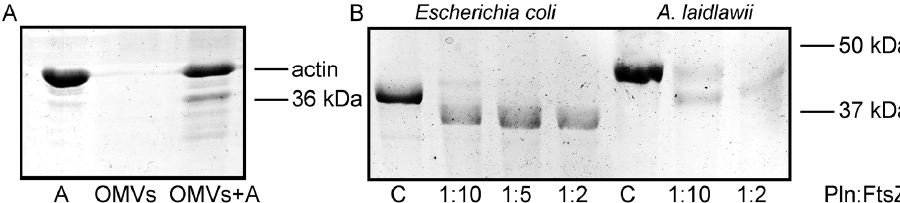
Figure 1. ( A ). The actin cleavage by the OMVs components. Purified OMVs were incubated with actin at the volume ratio of 1:1 for 18 h at 4 °C. A—control actin. ( B ). The FtsZ cleavage by protealysin in solution. Purified E. coli FtsZ and A. laidlawii FtsZ were incubated with protealysin in the mass ratio indicated below for 18 h at 4 °C. C—control (corresponding FtsZ,